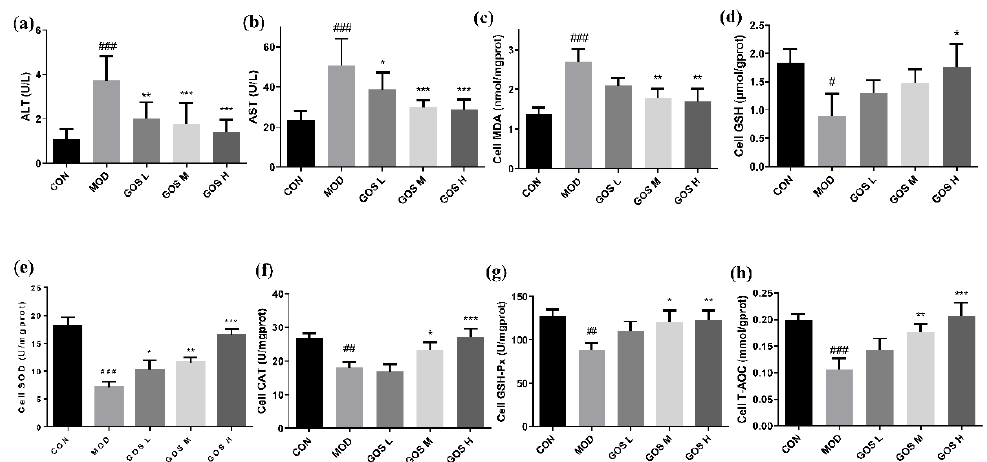
Figure 2. Effect of GOS on alcohol-induced injury, oxidative damage index, and antioxidant enzyme index in L02 liver cells ( n = 6, means ± SD). ( a ) ALT. ( b ) AST. ( c ) Cell MDA. ( d ) Cell GSH. ( e ) Cell SOD. ( f ) Cell CAT. ( g ) Cell GSH-Px. ( h ) Cell T-AOC. Notes: Compared with the MOD group, * p < 0.05, ** p < 0.01, and *** p < 0.001; compared with the CON group, # p < 0.05, ## p < 0.01, and ### p < 0.001.